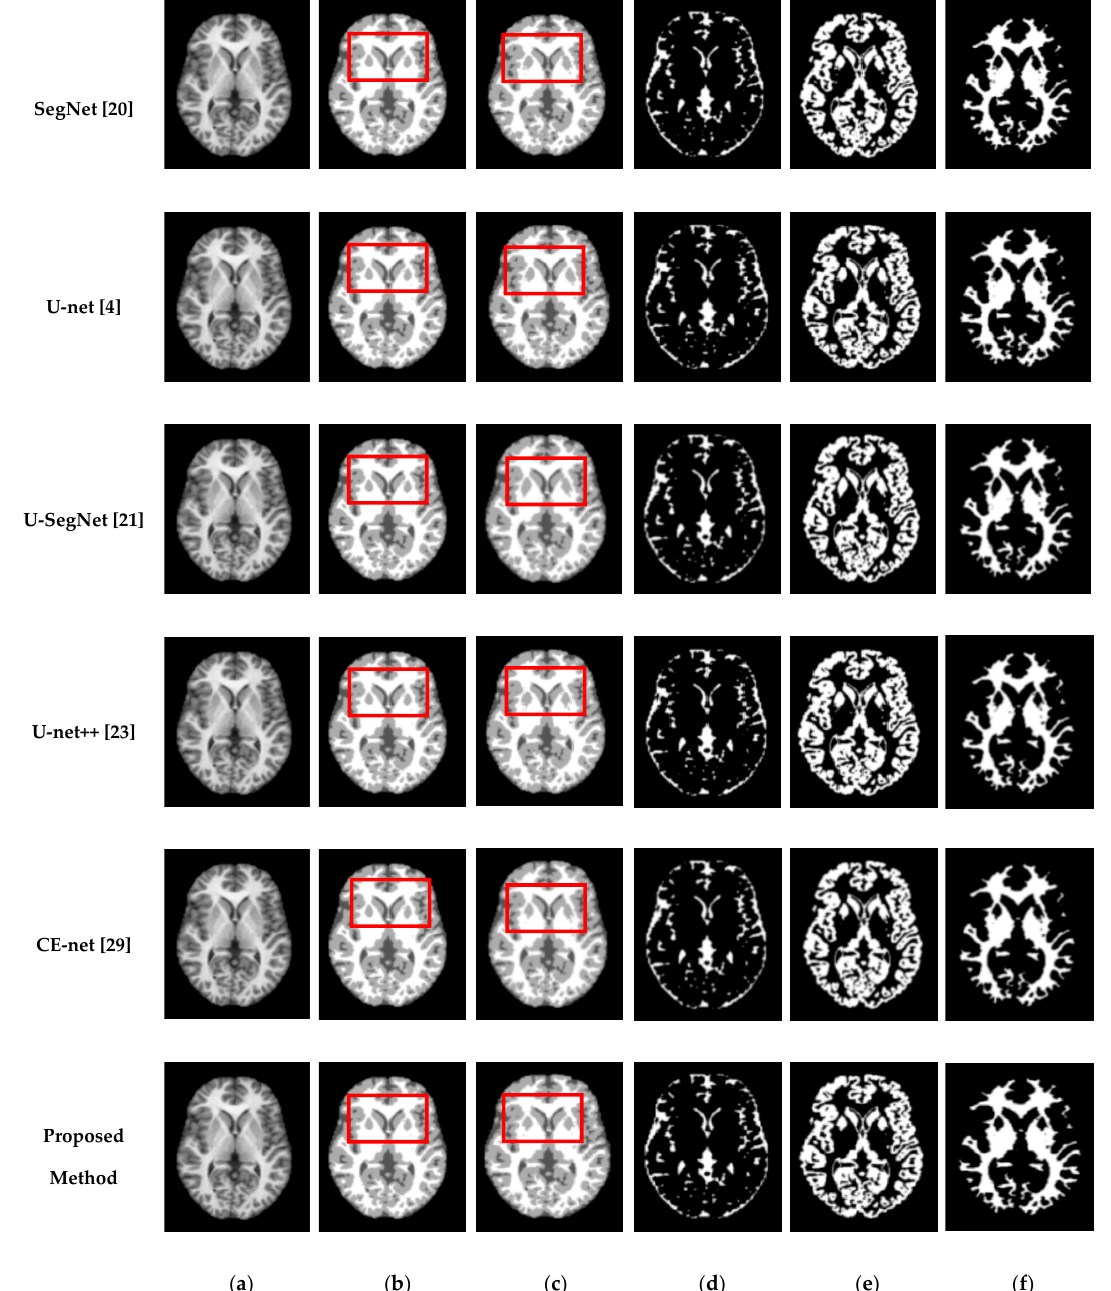
Figure 7. Segmentation results for GM, CSF, and WM from brain MRI image using the existing methods and the proposed method on OASIS dataset: ( a ) original input image; ( b ) ground-truth segmentation map; ( c ) their segmentation results obtained SegNet, U-net, U-SegNet, U-net++,CE-net, and the proposed method (top to bottom); ( d ) CSF maps obtained by SegNet, U-net, U-SegNet, U-net++,CE-net, and the proposed method (top to bottom); ( e ) GM maps obtained by SegNet, U-net, U-SegNet, U-net++,CE-net, and the proposed method (top to bottom); ( f ) WM maps obtained by SegNet, U-net, U-SegNet, U-net++,CE-net, and the proposed method (top to bottom).